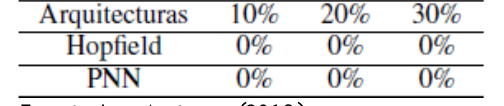
Tabla 2: % de error de clasificación n con diferentes % de datos Incompletos con clases separadas.